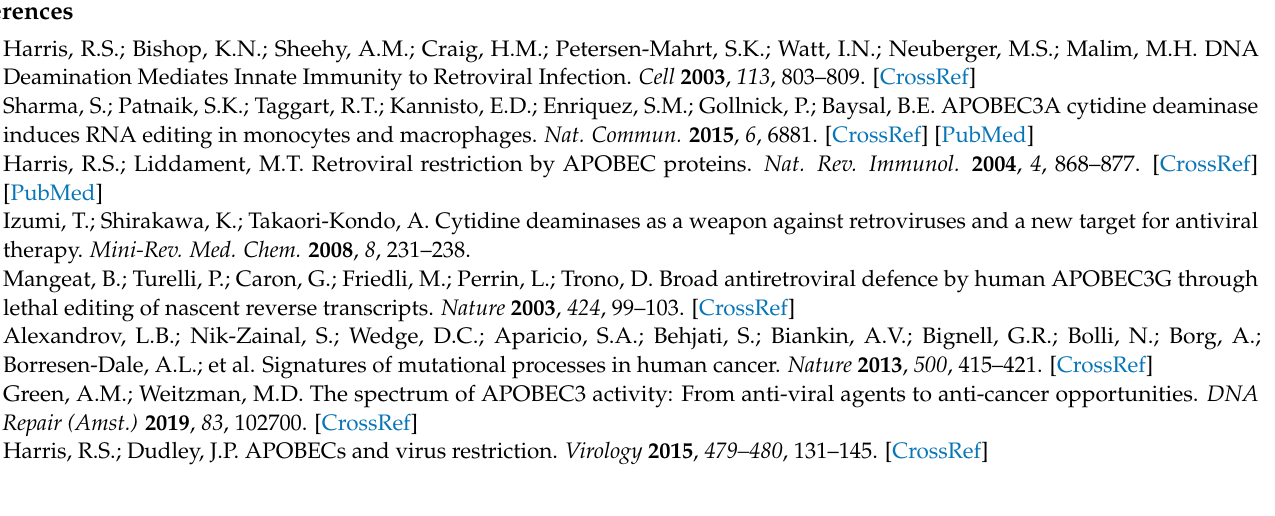
size exclusion profile; Figure S4: Ab initio shape restoration of A3G fl tetramer; Figure S5: SEC-SAXS analysis of the CCdZ-T 30 -oligo; Figure S6: SEC-FLPC profile comparison of apo A3G fl , CCdZ- T 30 -oligo (denoted in figure as CCdZ-40mer) and A3G fl /CCdZ-T 30 -oligo sample shows complex formation; Figure S7: SEC-SAXS analysis of sample of A3G fl / CCdZ-T 30 -oligo (denoted in figure as CCdZ-40mer); Figure S8: Singular value decomposition (SVD) of sample of A3G fl with CCdZ- T 30 -oligo; Figure S9: SEC-SAXS analysis of A3G fl / CCdZ-T 30 -oligo deconvoluted species; Figure S10: Modeling of A3G fl /CCdZ-T 30 -oligo complex; Figure S11: Fit of 40-mer oligonucleotide to data, where only ten residues are in contact in the vicinity of the catalytically active C-terminal domain; Figure S12: Tetramer model shown in Figure 8 (main text) is superimposed with the A3G fl tetramer envelope model (orange) shown in Figure S4; Table S1: SAXS structural parameters of the A3G fl ; Table S2: SAXS fitting and modeling parameters of the A3G fl sample; Table S3: SAXS structural parameters of CCdZ-T 30 -oligo; Table S4: SAXS fitting and modeling parameters of CCdZ-T 30 -oligo; Table S5: SAXS structural parameters of A3G fl in presence of CCdZ-T 30 -oligo; Table S6: SAXS ab initio modeling parameters of A3G fl in presence of CCdZ-T 30 -oligo